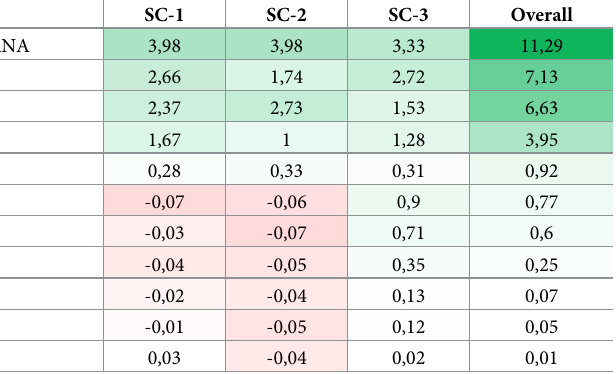
Fig 3. Dynamical evolution of the cell’s phenotype in SC-1(left), SC-2(center) and SC-3 (right). A heterogeneous epithelium is simulated in the different extracellular conditions (performed with MaBoSS [37]). The initial populations are a mix of H, V and IH. They are generated by defining the probability of H and then allocating the remaining proportionally to the endpoint probability of the first scenario. Each area represents a family of curves derived from the simulation at fixed initial conditions.